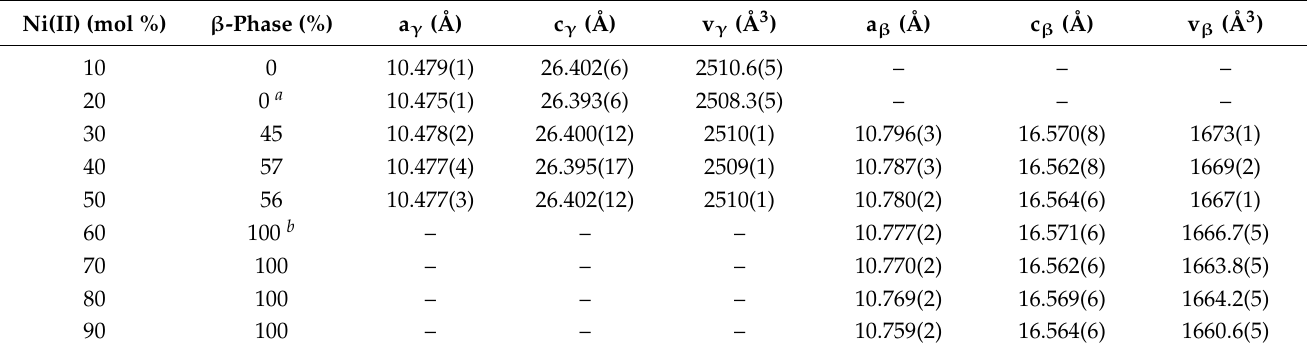
Table 6. Rietveld refinements of co-crystallizations of [Ni(bpy) 3 ](PF 6 ) 2 with [Zn(bpy) 3 ](PF 6 ) 2 .